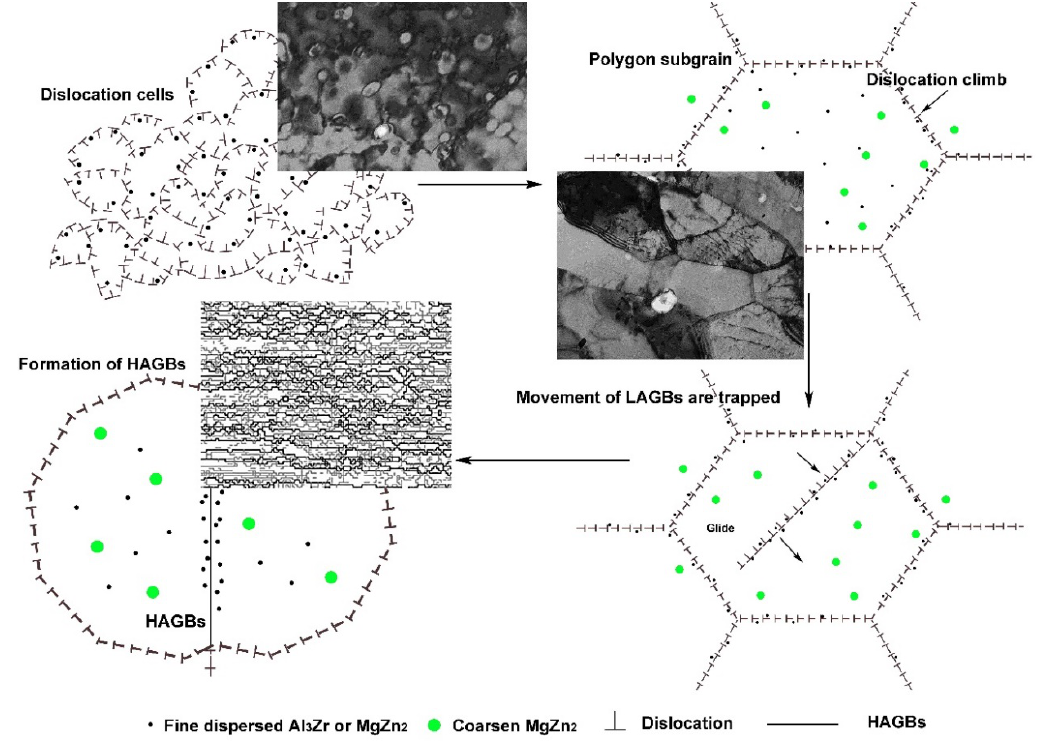
Figure 9. Schematic diagram of